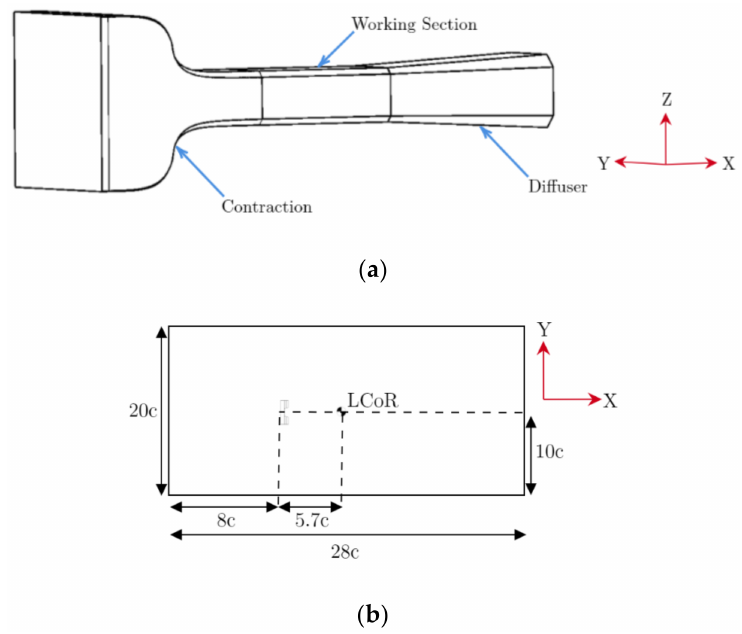
Figure 4. A schematic diagram showing an isometric view of the computational domains. ( a ) Nu- merical validation variant; ( b ) Full-scale simulation variant.